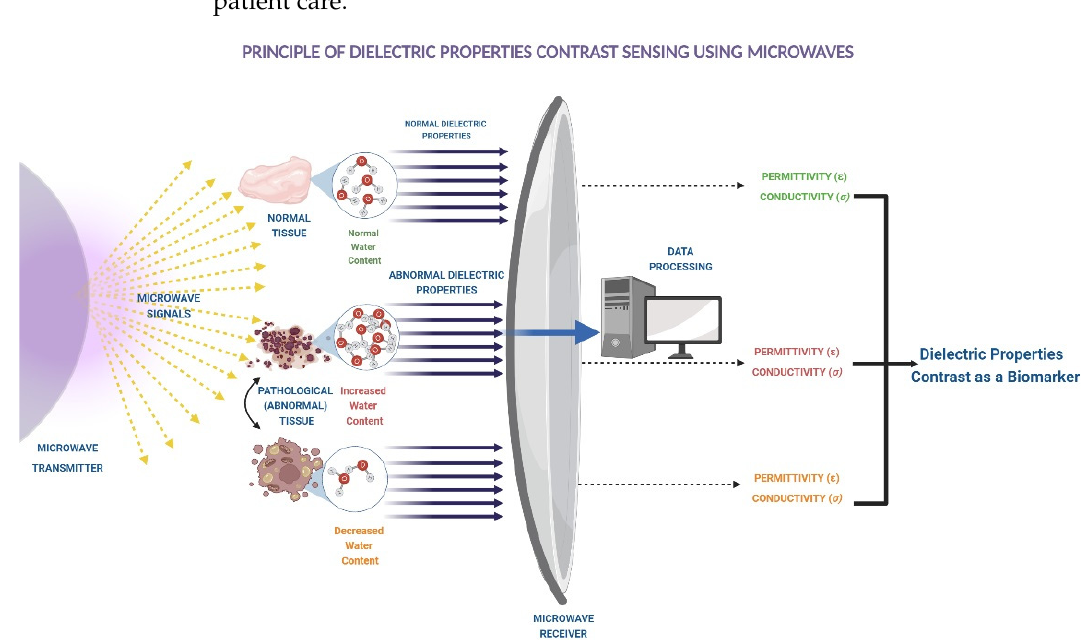
Figure 1. Principle of dielectric properties contrast sensing using microwaves [8].